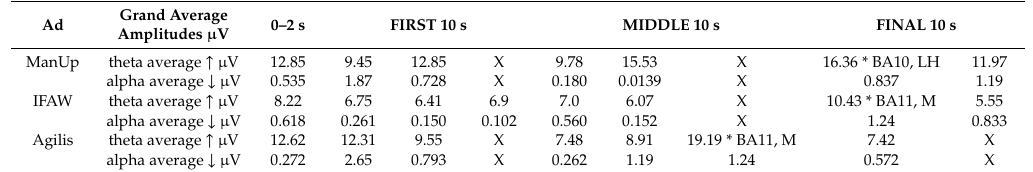
Table 2. ManUp, International Fund for Animal Welfare (IFAW), and Agilis grand average theta and alpha amplitudes µ V (from brand vision analyser (BVA)) for first, middle, and final 10-s